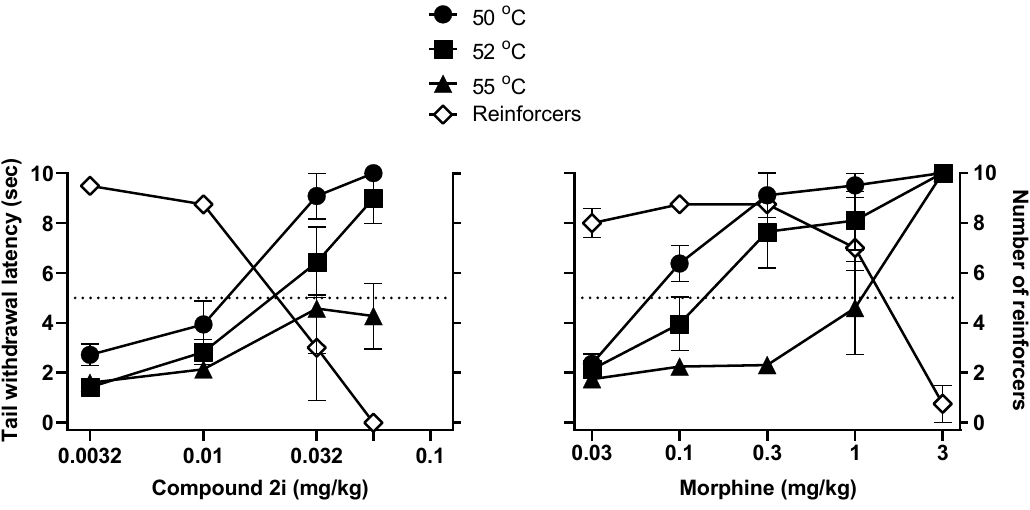
Figure 4. Effects of 2i on tail withdrawal latency from different temperatures of water (filled symbols) and operant behavior disruption (open symbols) in squirrel monkeys ( n = 4). Data are expressed as mean ± SEM ( n = 4).